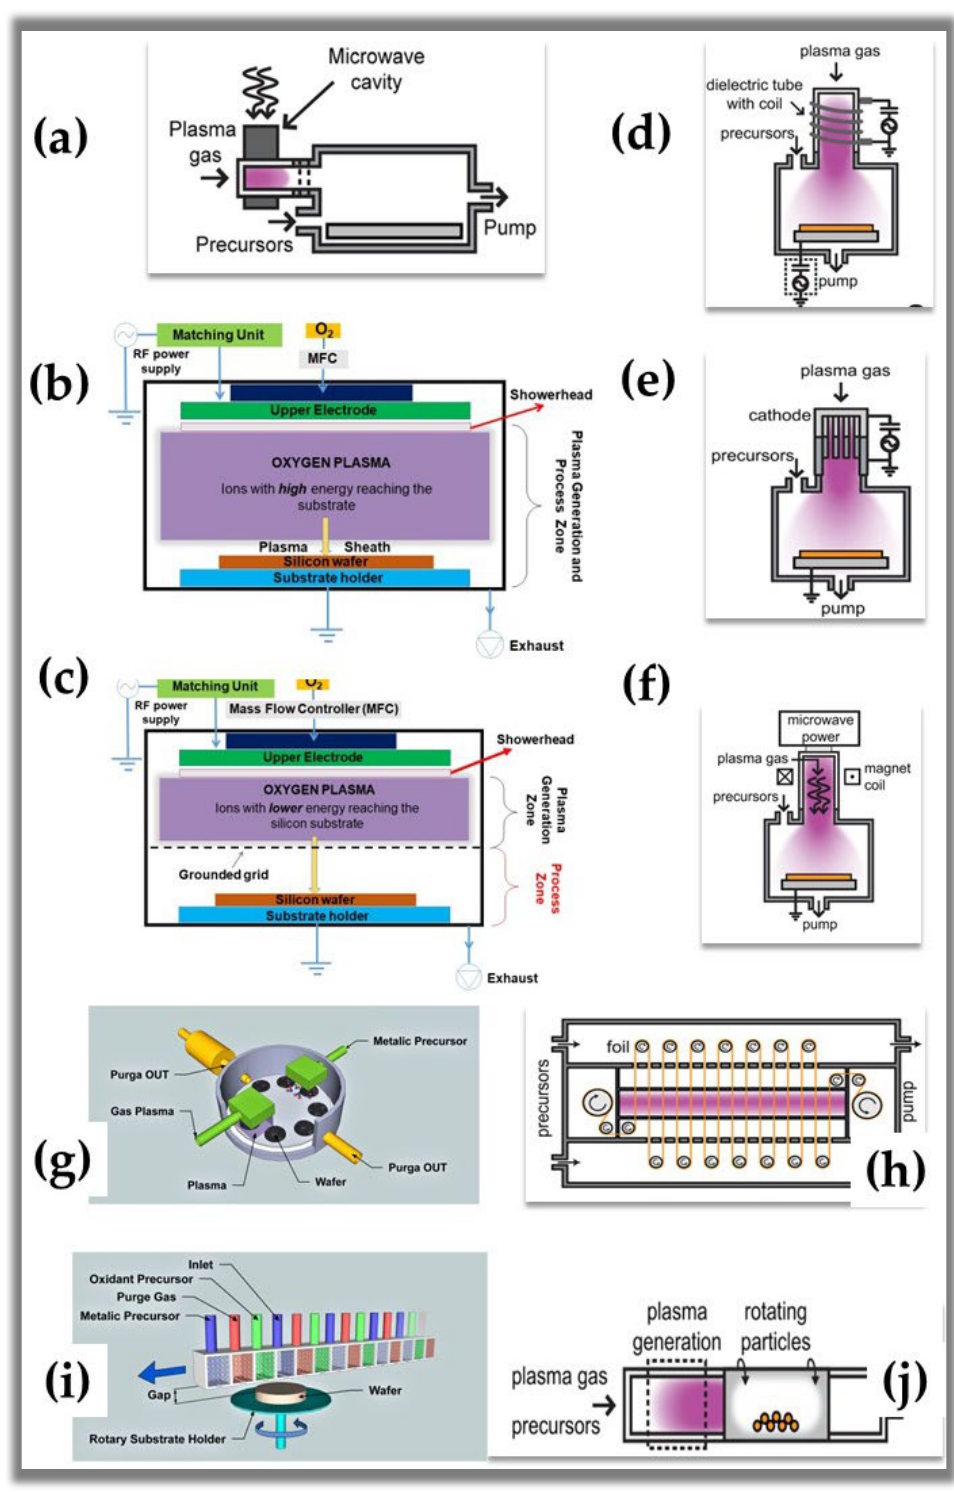
Figure 6. Schematic configuration of reactors used in plasma-assisted ALD [32,48–50,64–67]. Sub- figure ( a ) reprinted with permission from Ref. [48]. Copyright 2011, American Vacuum Society. Subfigures ( b , c ) reprinted with permission from Ref. [55] by Creative Commons 4.0. Subfigures ( g , i ) reprinted with permission from Ref. [32]. Subfigures ( d – f ) and ( h , j ) reprinted with permission from Ref. [50]. Copyright 2019, American Vacuum